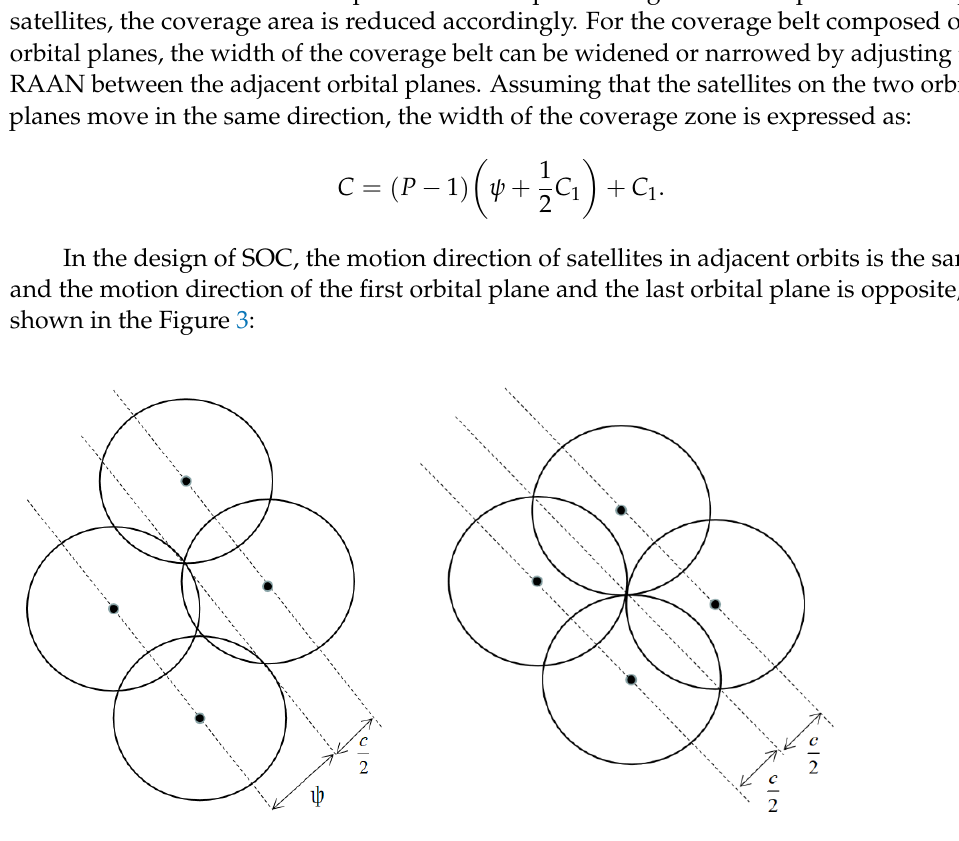
Figure 3. Coverage belt of same direction orbit and reverse orbit. The relation between the same direction orbit and the reverse orbit is as